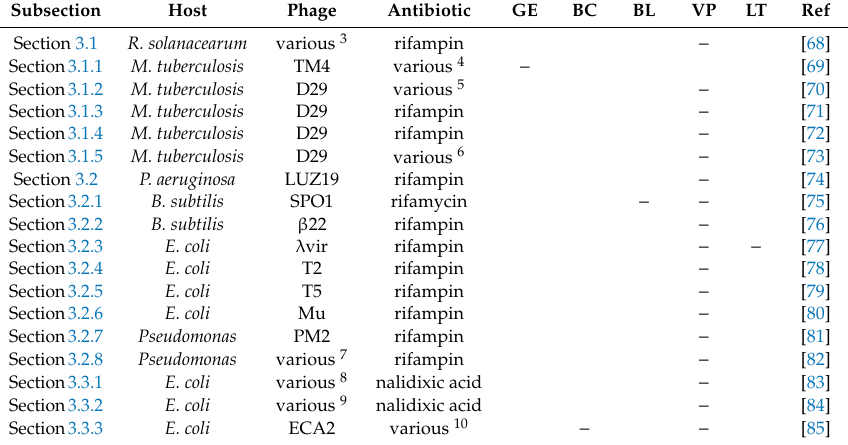
Table 1. Studies suggesting inhibition of phage infection activity in the presence of antibiotics 1,2